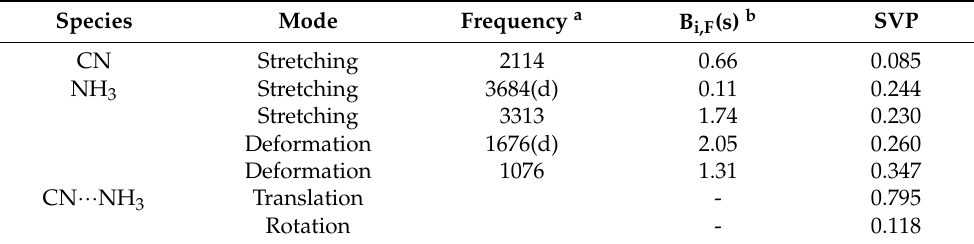
Table 6. B i,F (s) and sudden vector projection (SVP) model coupling terms on the PES-2020 surface for the CN + NH 3 reaction.